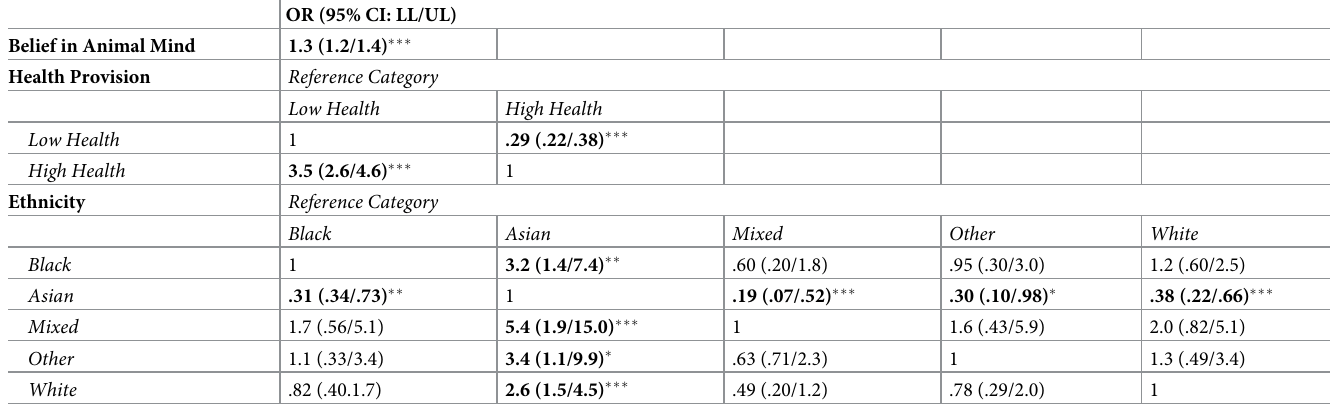
Table 4. Odds ratios of significant predictors of ratings of the importance of minimising health